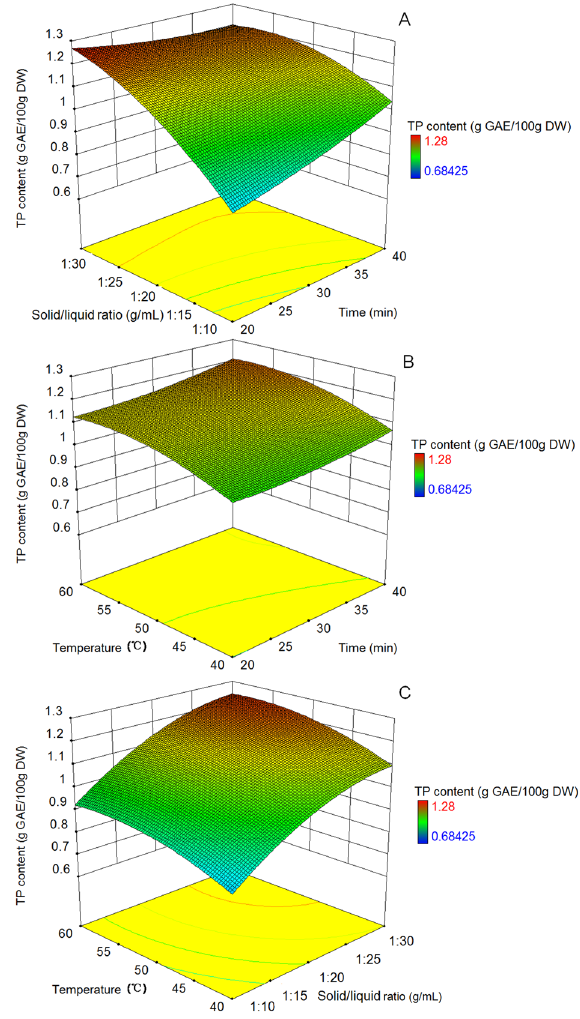
Figure 3. Interaction effect ( A ) between extraction time and solid/liquid ratio, ( B) between extraction time and temperature, ( C) between extraction solid/liquid ratio and temperature on TP content obtained from CCC design.